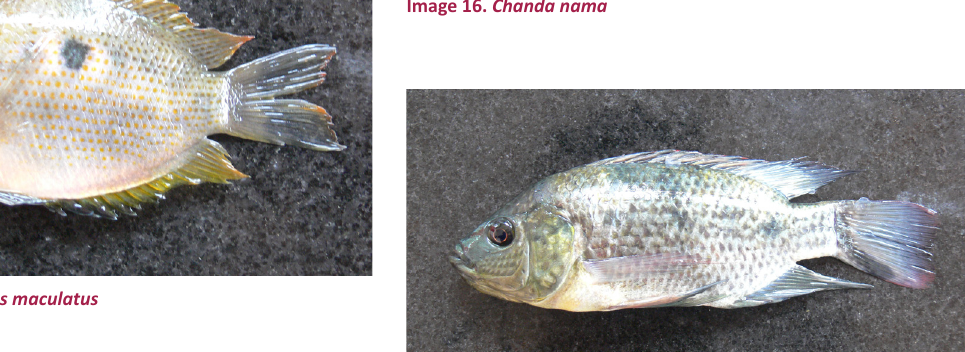
Image 16. Chanda nama